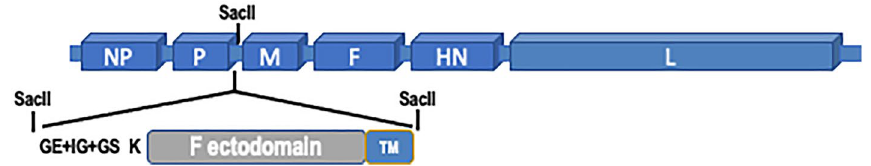
Figure 1. Construction of a recombinant NDV expressing a codon-optimized bovine RSV F protein. A functional transcription unit was inserted in the pNDV (LaSota strain) rescue plasmid at a unique restriction site (SacII) between the genes P and M. The additional transcription unit contains: NDV regulatory sequences Gene end-Intergenic-Gene Start (GE + IG + GS), Kozak sequence (K), a codon optimized synthetic sequence encoding the ectodomain of the bovine RSV F protein fused to the transmembrane and cytoplasmic domains (TM) of the NDV F